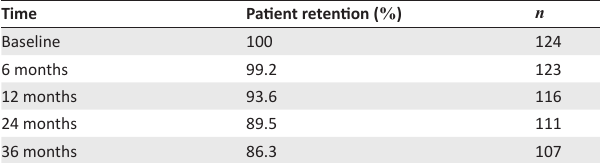
TABLE 4: Patient retention in care at time periods.